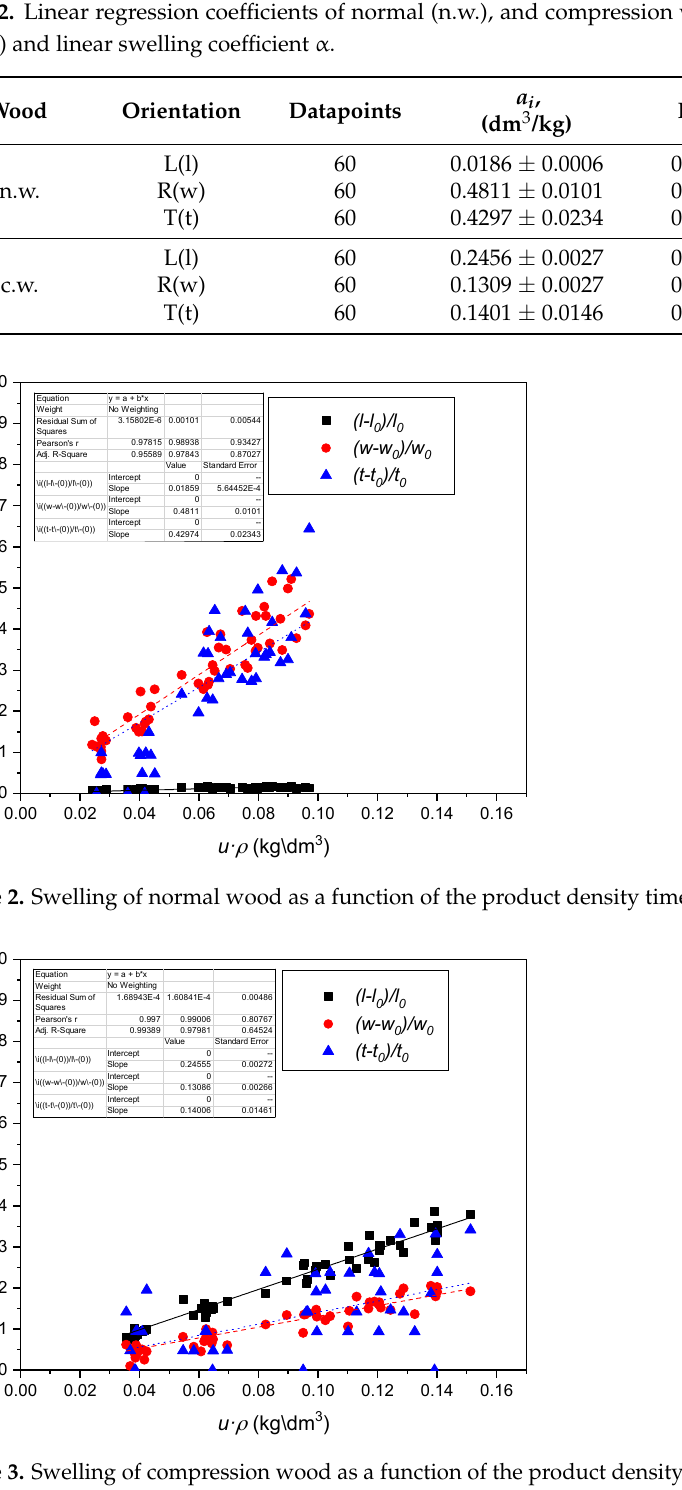
Figure 3. Swelling of compression wood as a function of the product density times moisture content.